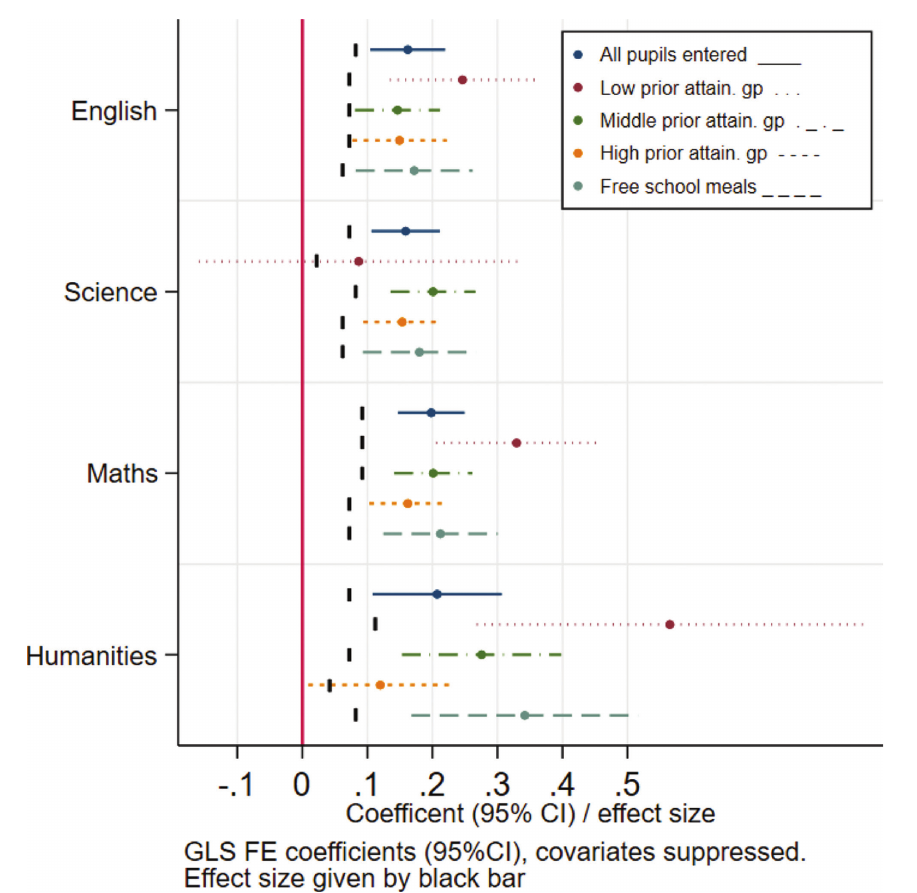
Figure 1: Regression coefficients and effect size for KS4 hours/student (by subject and sub-group) (Source: SWC, 2010–14, and matched